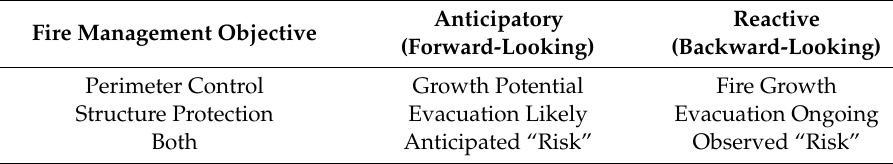
Table 1. Expected resource ordering